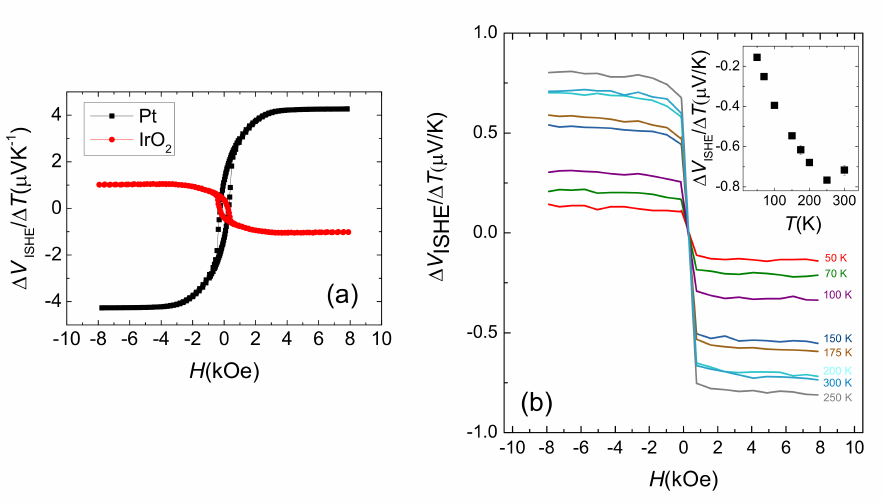
Figure 5. ( a ) Comparison between the ∆ V ISHE measured as a function of the magnetic field for γ –Fe 2 O 3 /Pt bilayer and a γ –Fe 2 O 3 /IrO 2 bilayer; ( b ) Evolution with temperature of the measured ∆ V ISHE output excited by the LSSE in the sample with t IrO 2